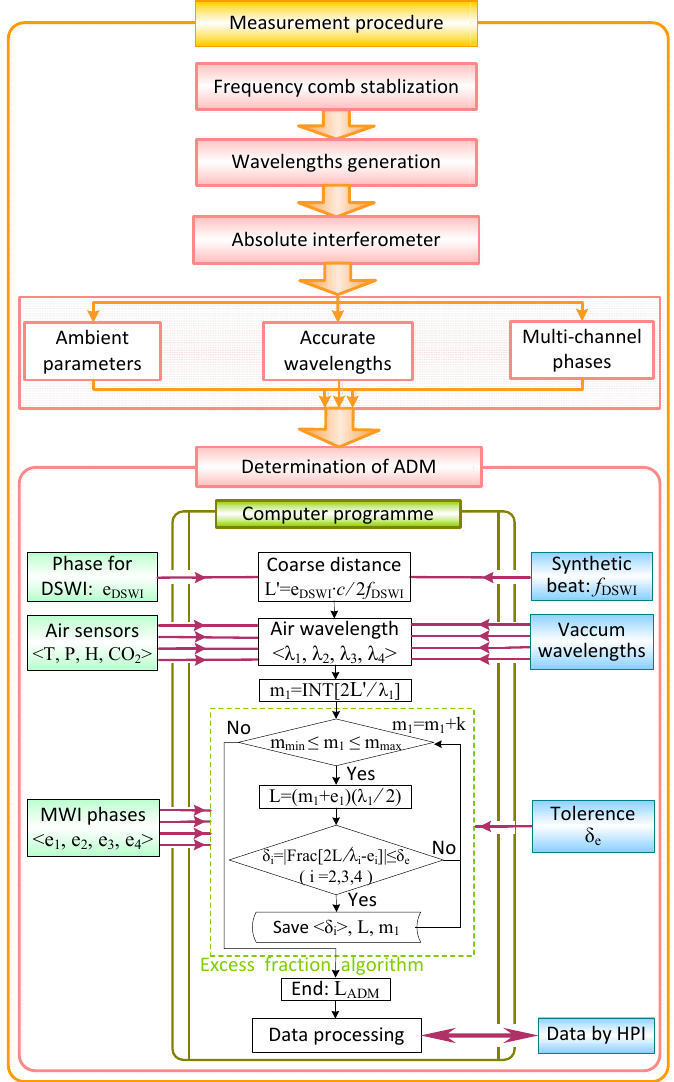
Figure 4. Measuring procedure for real-time and meter-scale absolute distance measurement.